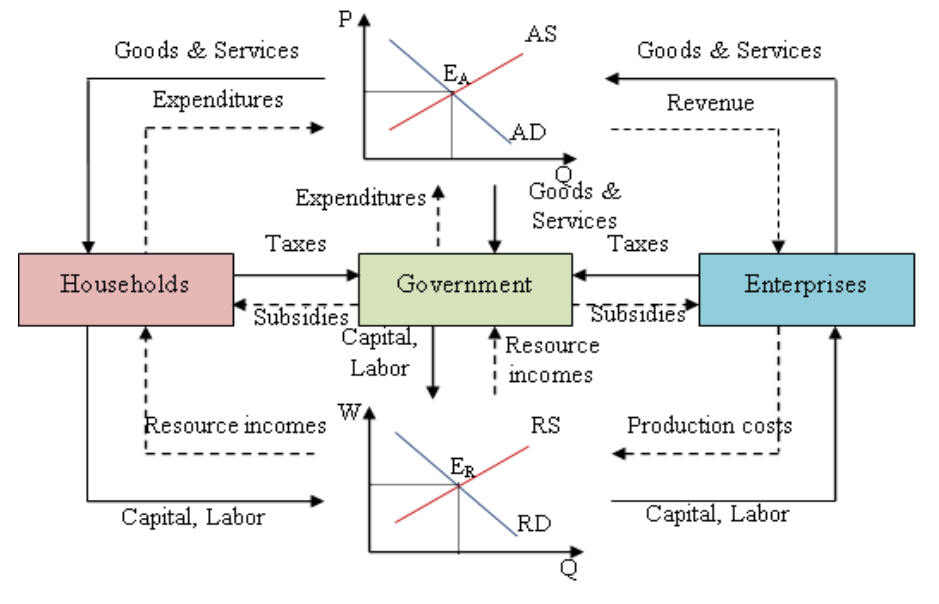
Figure 1. The structure of the simple economy.